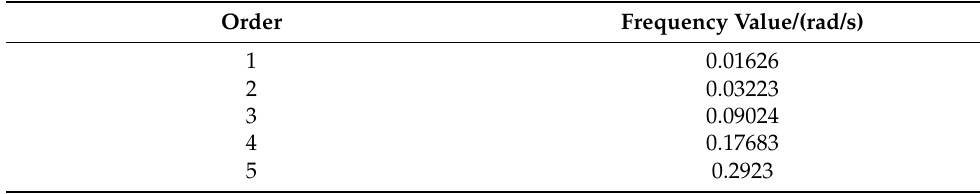
Table 2. Natural frequencies of actual leaching strings in salt caverns.